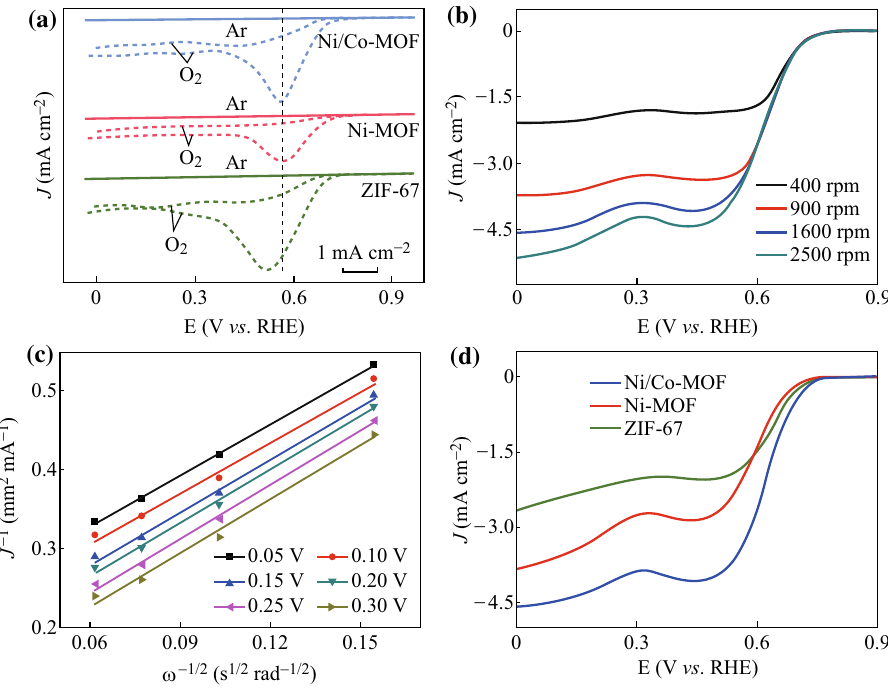
Fig. 4 a CV curves in Ar-saturated ( solid curves ) and O 2 -saturated ( dashed curves ) solutions with a sweep rate of 50 mV s - 1 . b RDE polarization curves of Ni/Co-MOF nanoflakes at different rotation speeds. Scan rate: 10 mV s - 1 . c Koutecky–Levich plots of Ni/Co-MOF nanoflakes at various potentials. d RDE polarization curves of samples at a rotation rate of 1600 rpm. Scan rate: 10 mV s -